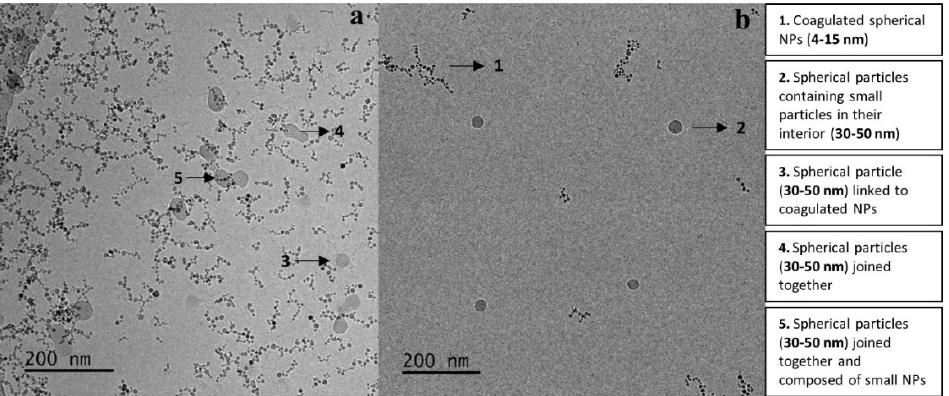
Figure 10. Cryo-TEM micrographs ( a , b ) of the MNPs-hybrid complexes and explanations of the structures observed at different points of the